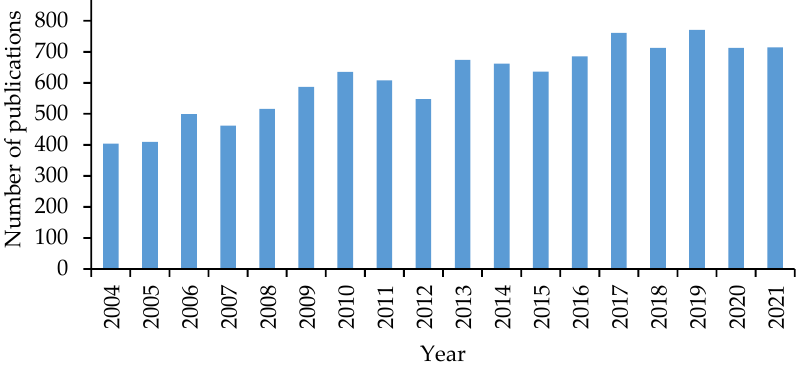
Figure 1. Distribution of publications on corrosion monitoring over time (2004–2021) in the SCOPUS database.